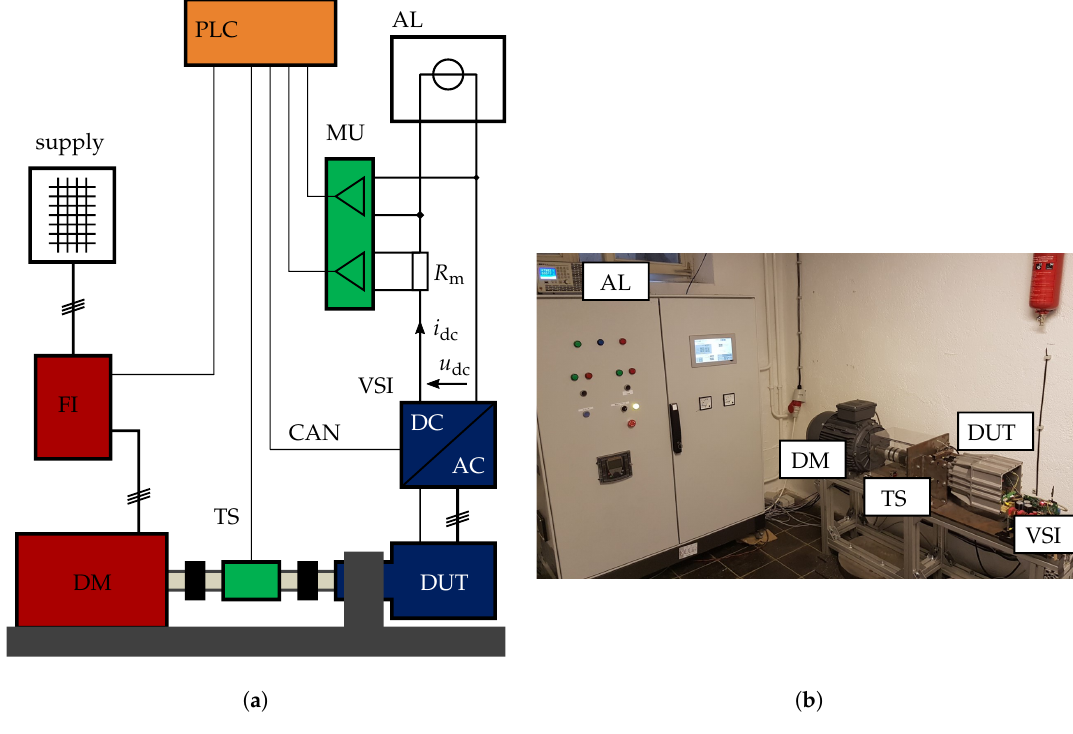
Figure 8. Illustration of the test bench. ( a ) Schematics of the test bench; and ( b ) Photograph of the test